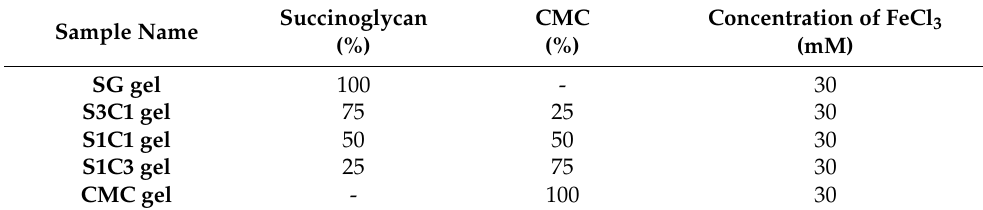
Table 1. Composition of Composition of SG/CMC IPN